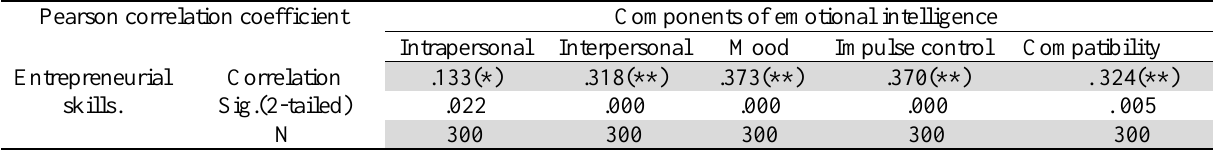
The summary of Pearson correlation test between emotional intelligence and Entrepreneurial skills Pearson correlation